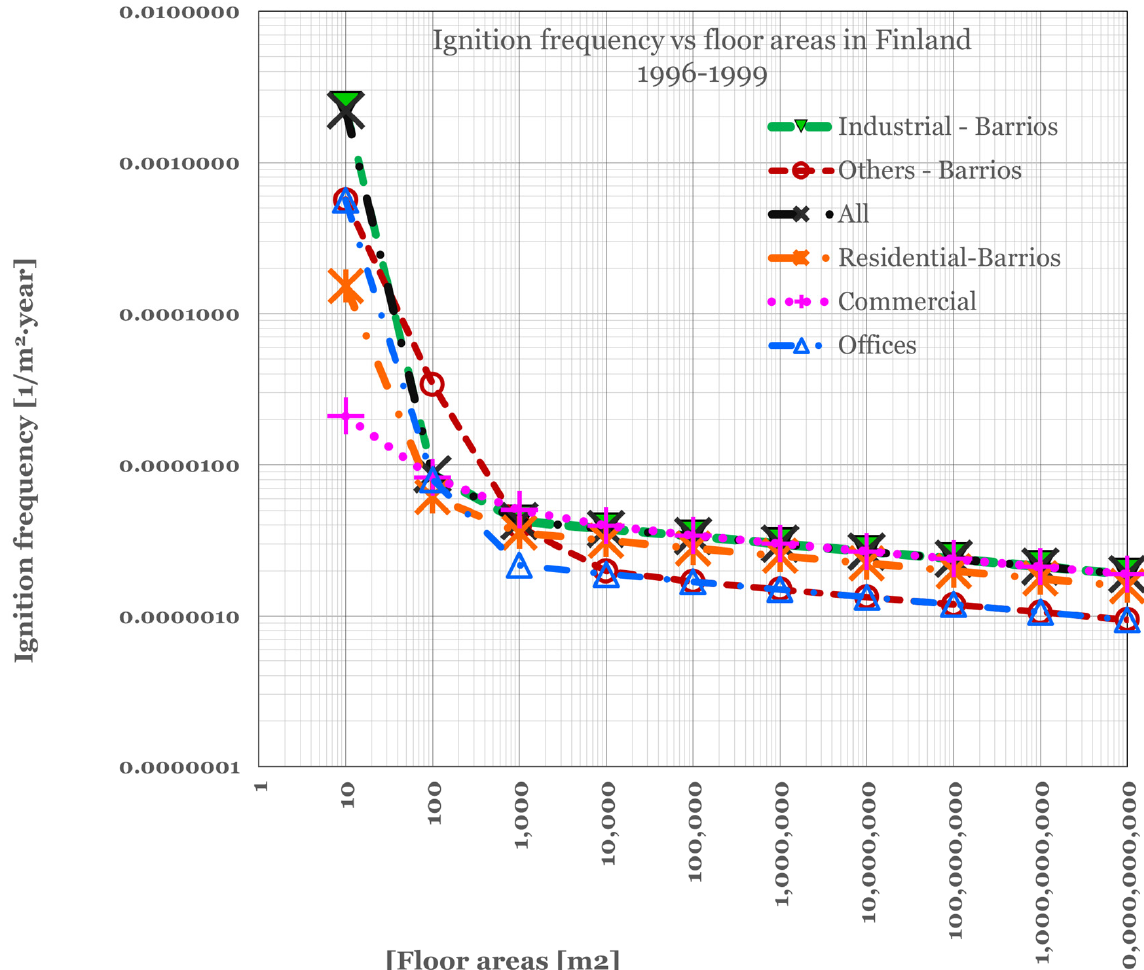
Figure 12. Generalized Barrois curves for building categories in Finland 1996-1999.